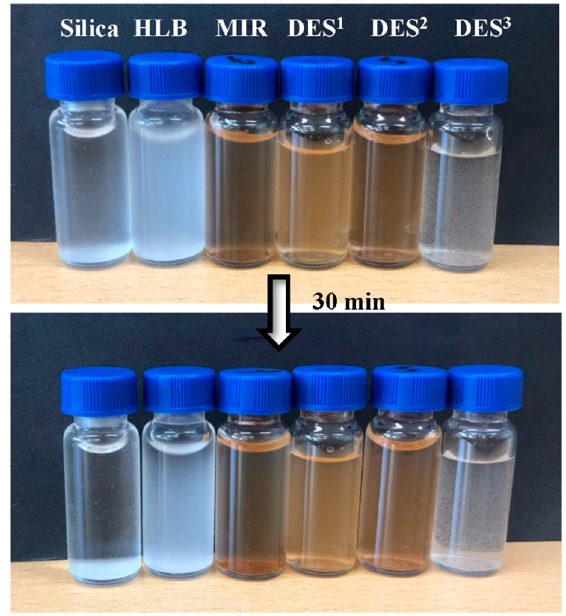
Figure 6. Hydrophilicity performance of the different adsorbents.